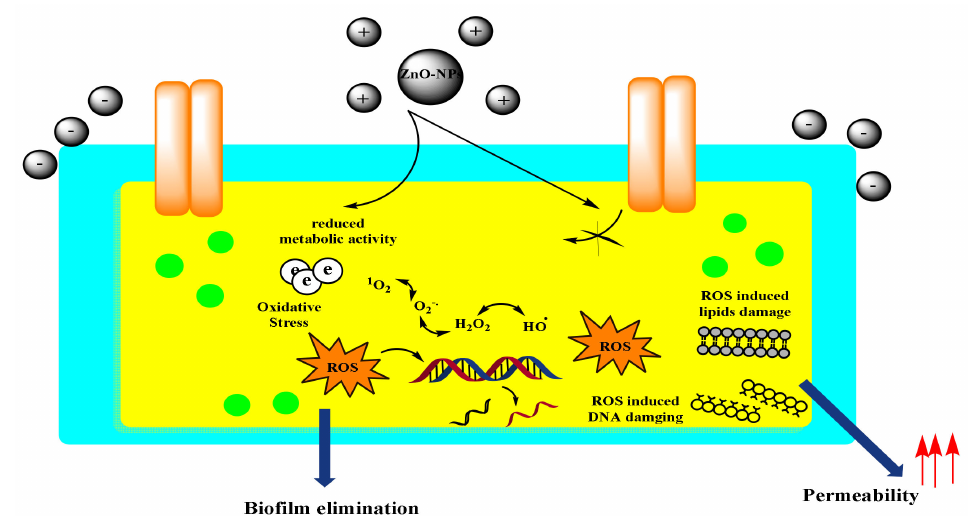
Figure 6. The role of metal-based NPs in oxidative stress.